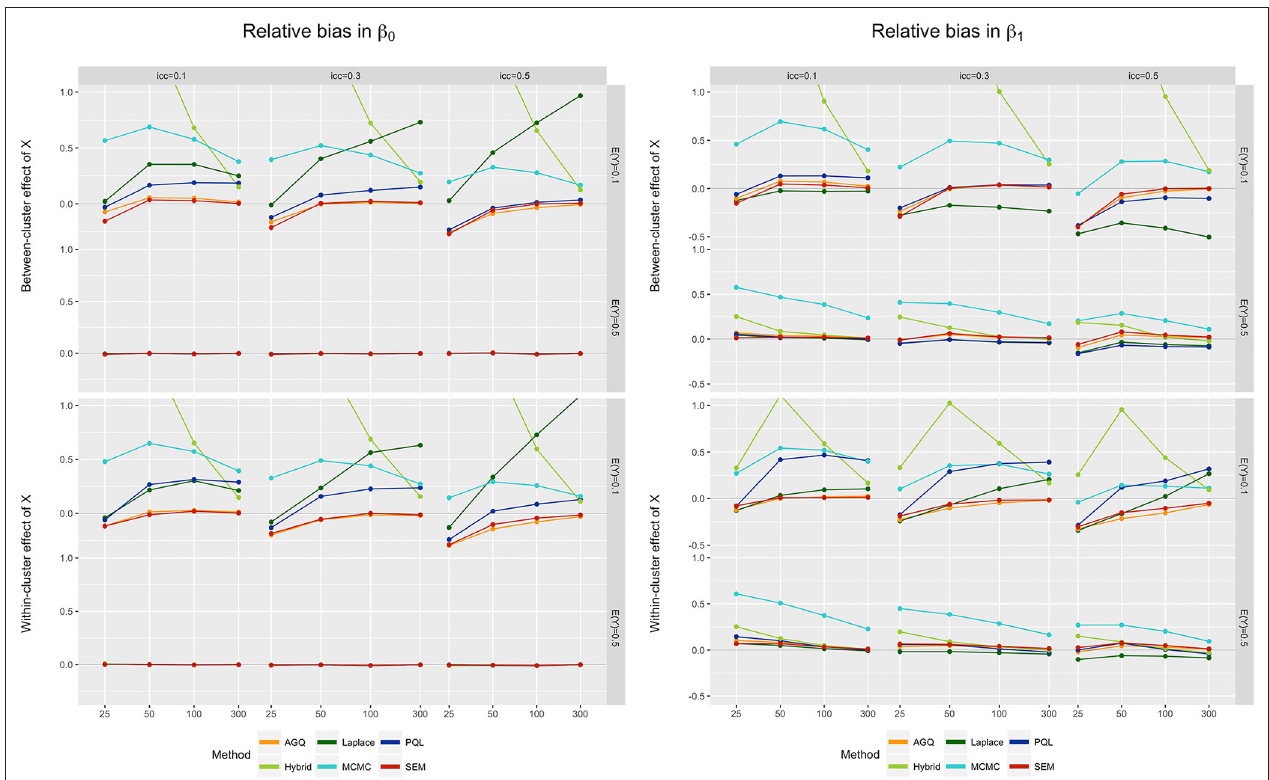
FIGURE 3 | Relative bias in β 0 (left) and β 1 (right) for the six approaches, for different measurement levels of X (within- or between clusters), outcome prevalence (0.1 and 0.5), icc l (0.1, 0.3, and 0.5), and sample size (25, 50, 100, and 300). These results stem from simulation runs where all methods